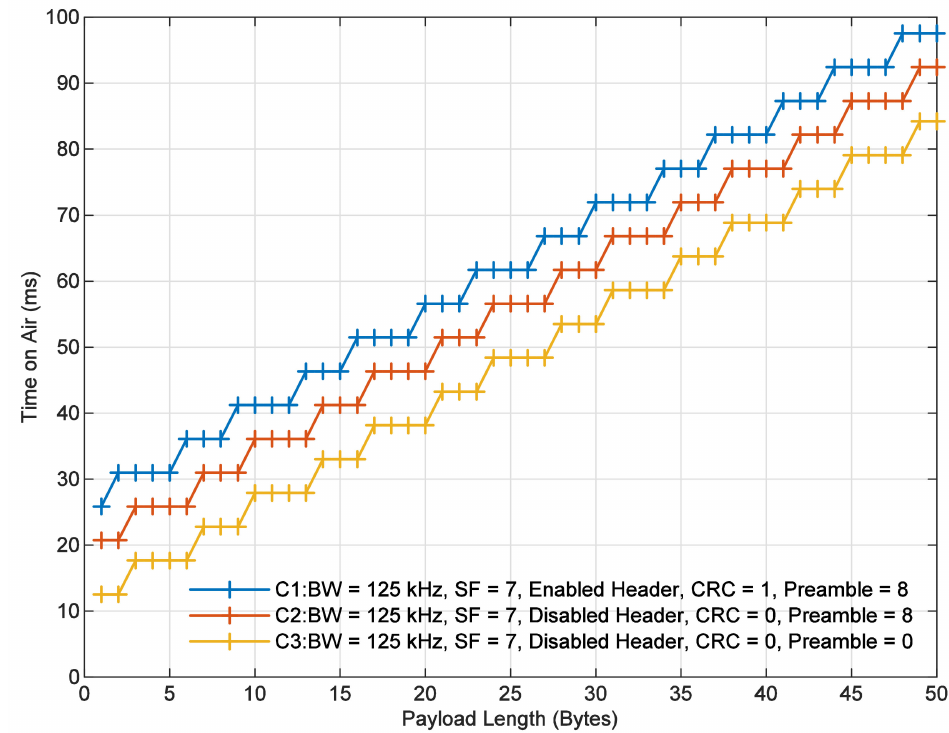
Figure 4. Time on air of the LoRa PHY structure for the analyzed configurations, C1, C2, and